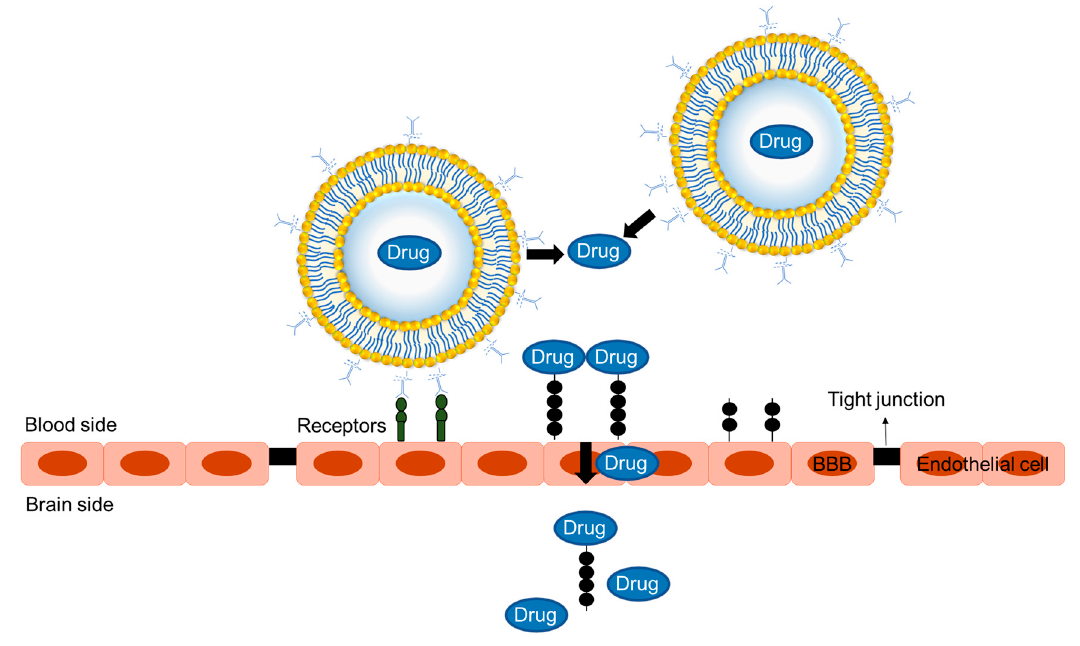
Figure 5. The mechanism of drug delivery across the BBB using ligand-targeted immunoliposomes.